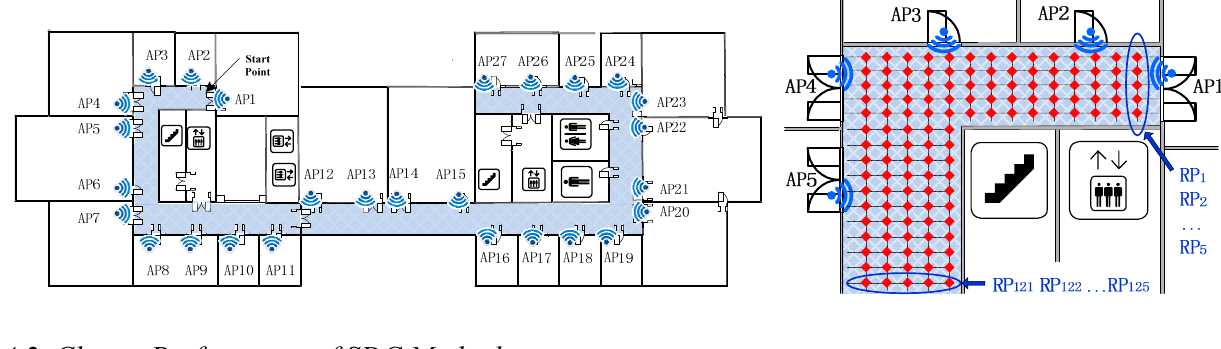
Figure 4. Floor plan for the indoor positioning experiment and reference point setting.